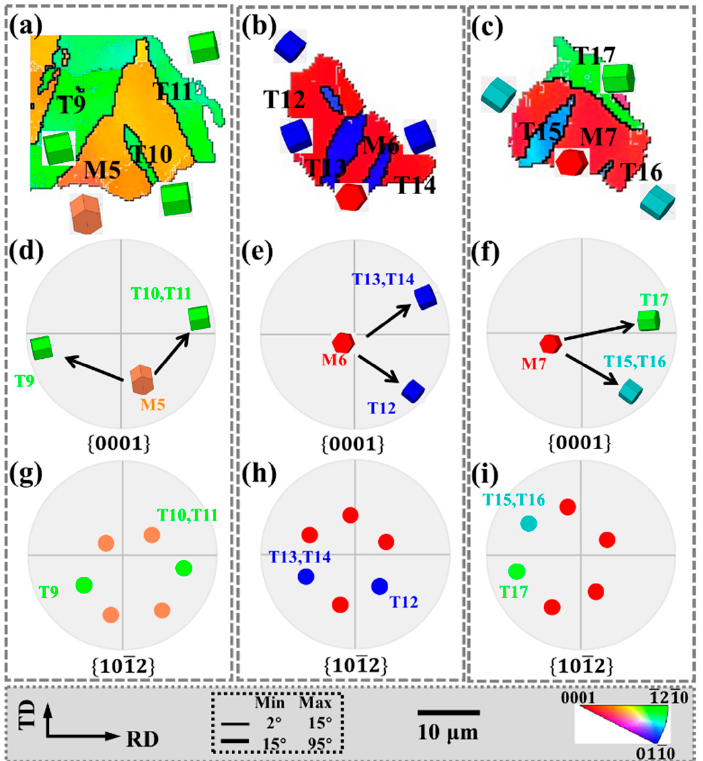
Figure 8. Non-parallel twin of the red circle region in Figure 4: ( a – c ) the IPF, ( d – f ) {0001} pole figure and ( g – i ) (cid:4668)101 (cid:3364) 2(cid:4669) pole figure. and ( g – i ) (cid:8) 1012 (cid:9) pole